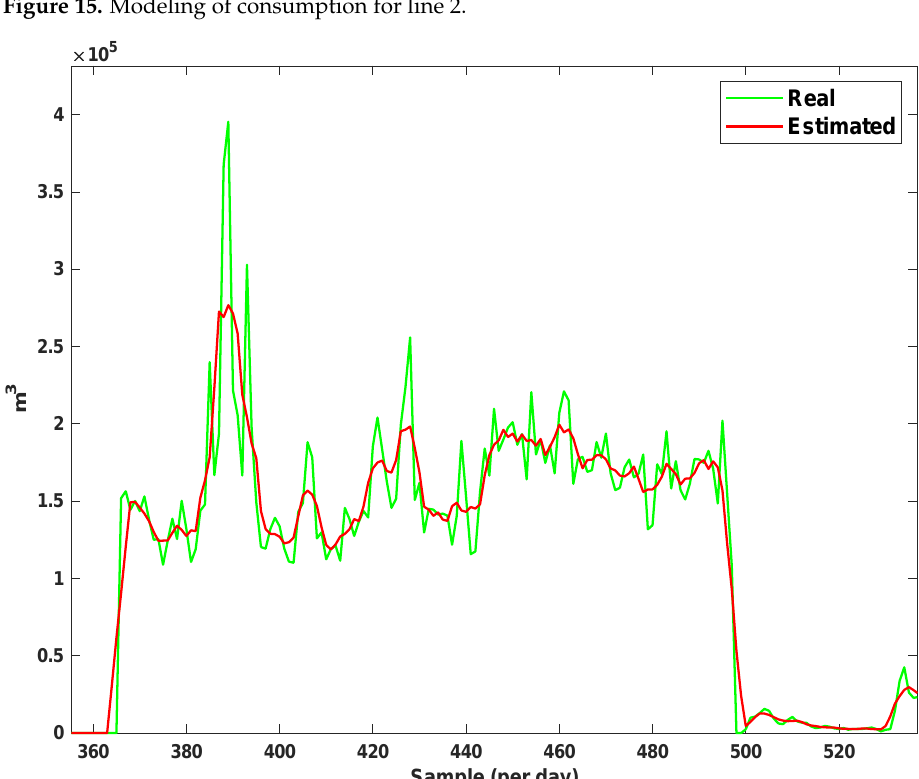
Figure 16. Modeling of consumption for line 2: Zoomed